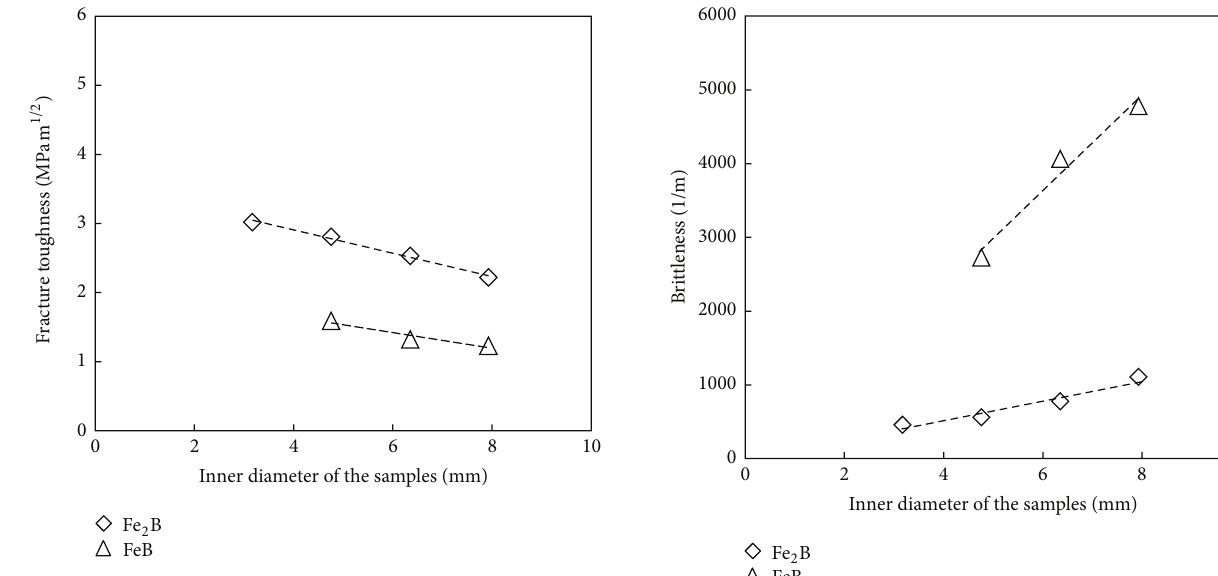
Figure 10: Behavior of the fracture toughness of both FeB and Fe 2 B phases as a function of the boron potential represented by the inner diameter of the samples. Table 6: Brittleness values of the FeB and Fe of the boron potential represented by the inner diameter of the samples.